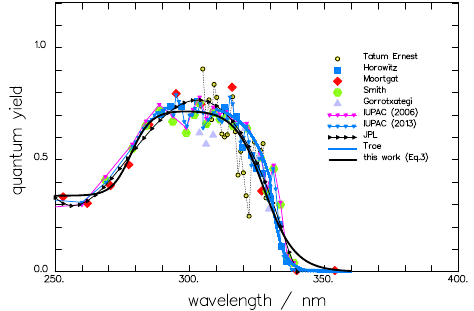
Figure 1. Spectrum of the quantum yield of the radical channel of the CH 2 O photolysis at room temperature. Measured data used for the fit are indicated by the large filled symbols (Horowitz and Calvert, 1978; Moortgat et al., 1983; Smith et al., 2002; Gorrotx- ategi Carbajo et al., 2008). The present fit and the theoretical curve from Troe (2007) are given by full lines. Recommended data are represented by small symbols connected by a thin line: JPL (Sander et al., 2011), and IUPAC (2006, 2013). The line structure observed by Tatum Ernest et al. (2012) is indicated by open circles and a dotted